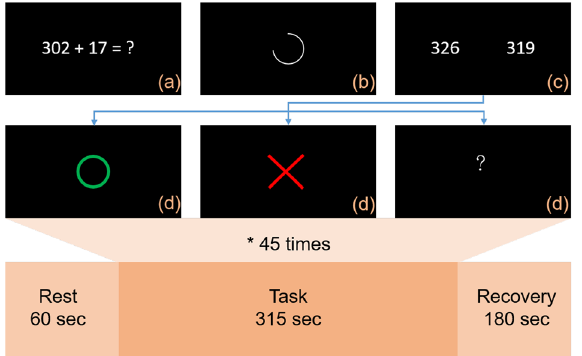
Figure 9. The MAT architecture. ( a ) A two-/three-digit addition/subtraction question will be displayed at the center of the screen for 1 second. ( b ) A countdown circle will be displayed on the screen for 4 seconds to remind the subject the remaining time to think. ( c ) The screen will be divided into two areas to display an answer separately. Subjects had 1 second to select the correct answer. ( d ) The screen shows a feedback for the result for 1 second. If the answer was correct, a green circle would be displayed; if the answer was wrong, a red cross would be displayed; if the correct answer was not selected in time, a white question mark would be displayed. Performing ( a − d ) once is a cycle, and the task stage includes 45